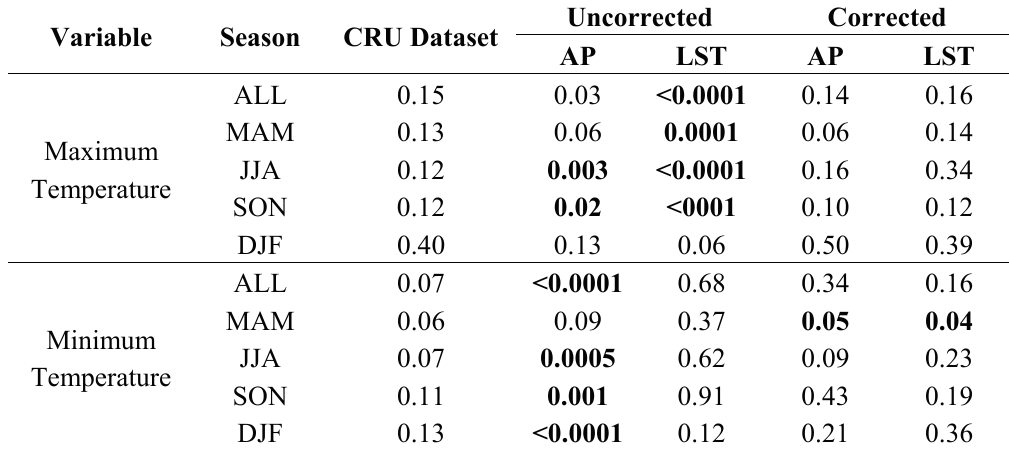
Table 2. Test statistics for one-way ANOVA testing differences between land cover classes of Mean Absolute Error (MAE) values between ASOS observation data vs. the Climate Research Unit (CRU) dataset and monthly air temperature estimates with or without the correction using the CRU data. Values in bold indicate that there is a significant difference at the 95% confidence level.